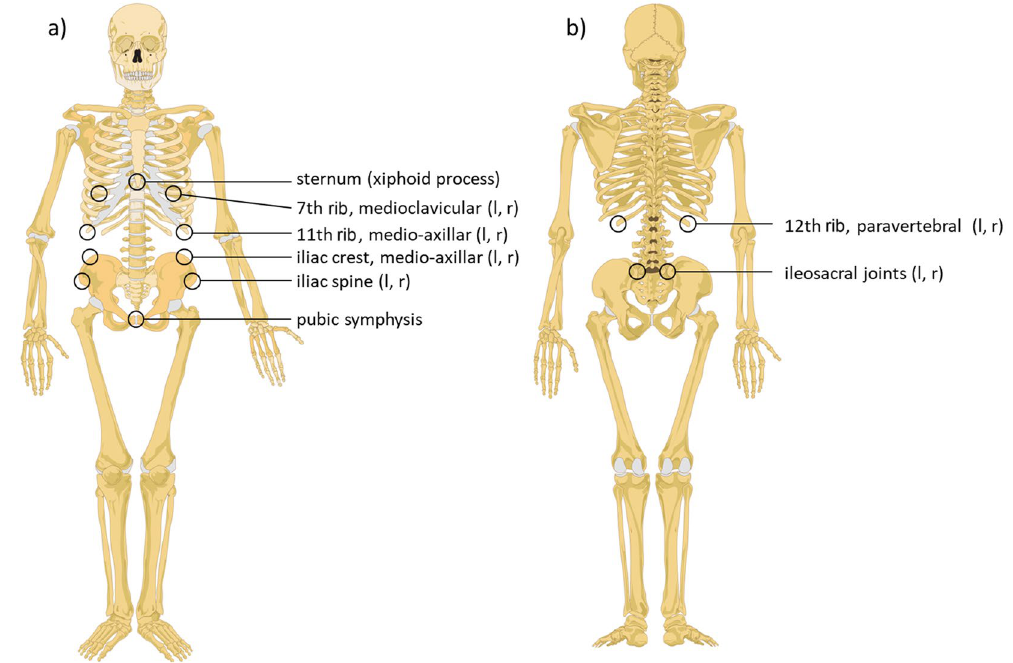
Figure 2. Positions of hemispherical markers attached to the skin of participants bounding the abdominal volume for the development of the 3D body scan algorithm for automated determination of the abdominal volume. Fourteen hemispherical markers were attached to the front (panel a) and rear (panel b) part of the participants’ skin to represent internal anatomical structures bounding the abdominal volume. Based on scan pictures taken with these markers accordingly attached to the skin, the 3D body scan algorithm for automated determination of abdominal volume was developed. Figure modified based on graphs obtained from Wikimedia commons, front: https://commons.wikimedia.org/wiki/File:Human_skeleton_front_en.svg#/ media/File:Human_skeleton_front_-_no_labels.svg; rear: https://commons.wikimedia.org/wiki/File:Human_ skeleton_back_en.svg#/media/File:Human_skeleton_back_en.svg. l, left; r,